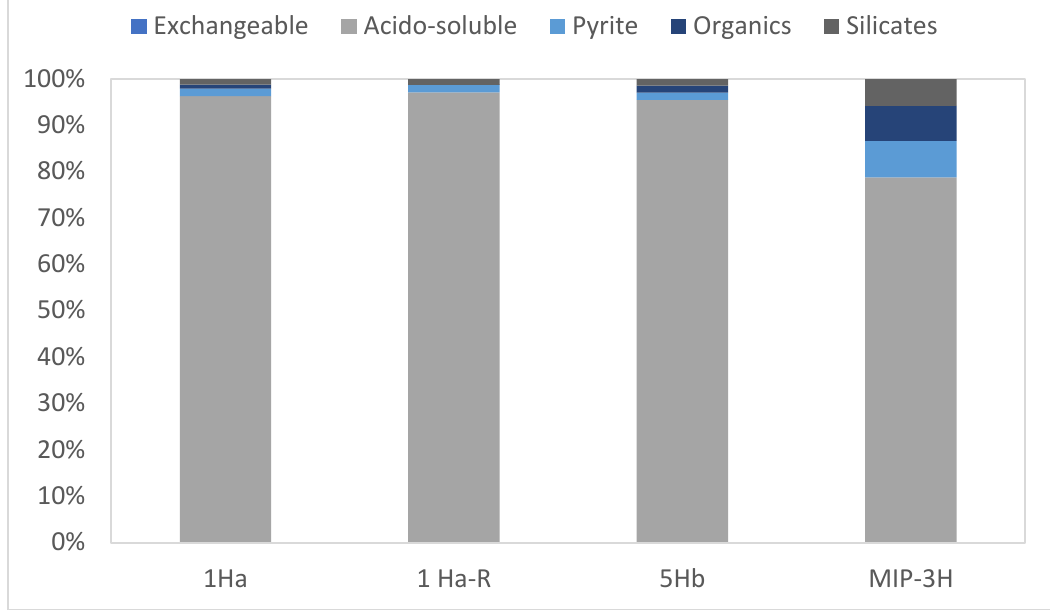
Figure 5. Total REY distribution in the extracted rock fractions.